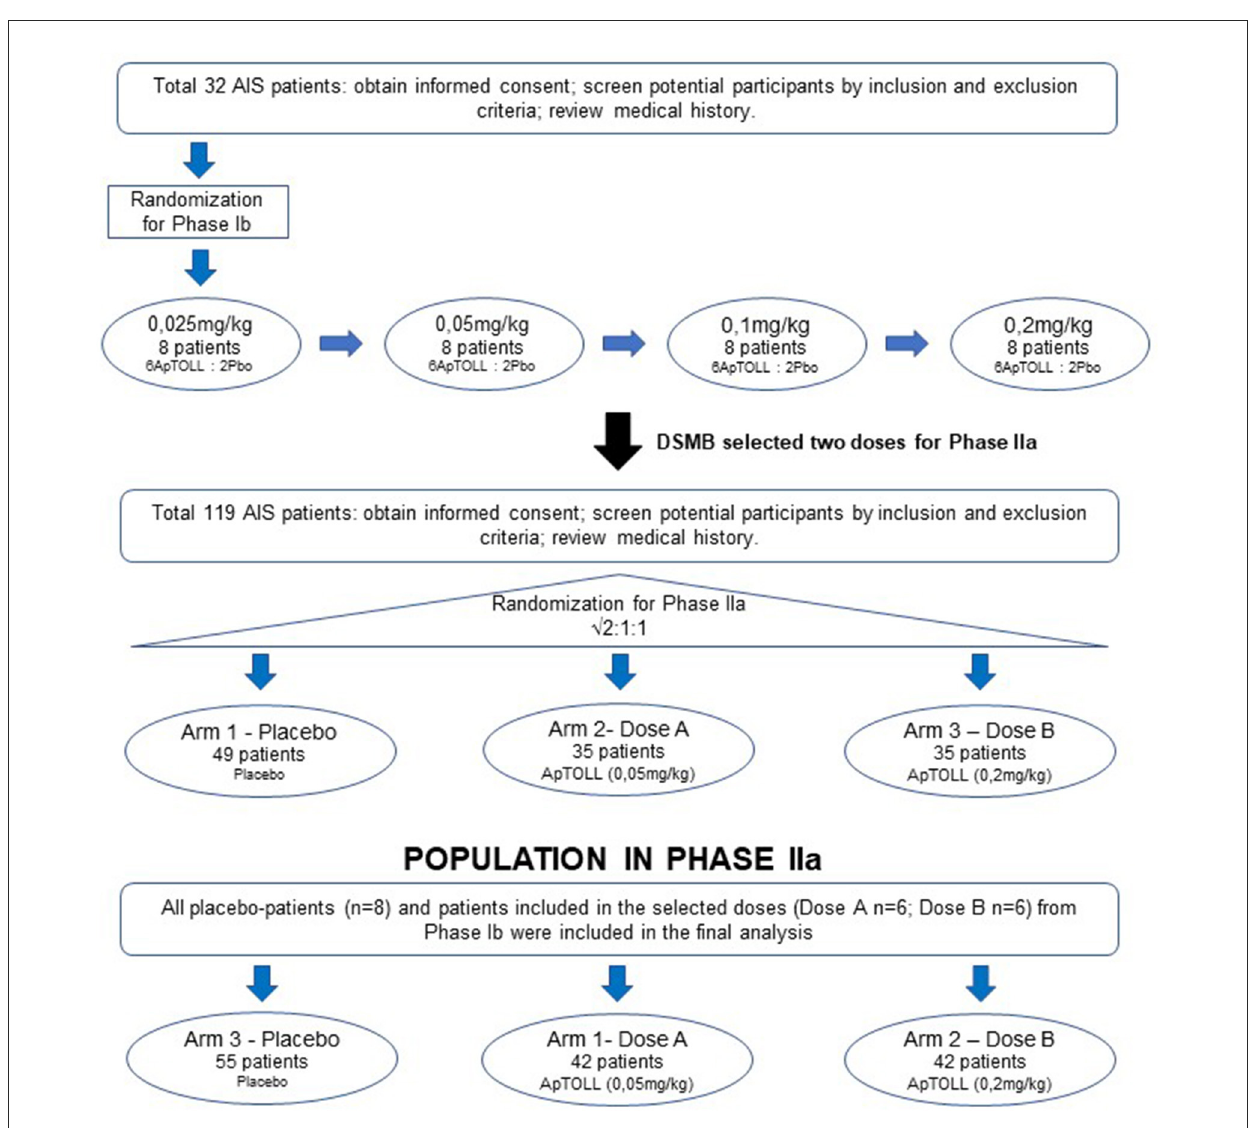
FIGURE1 Scheme of APRIL trial. APRIL is divided into two Phases. Phase Ib is a single ascending dose where 8 patients (6 ApTOLL: 2 Placebo) will be enrolled in 4 sequential ascending dose arms (0.025, 0.05, 0.1, and 0.2 mg/kg). After analyzing safety results from Phase Ib, the DSMB will select two doses to be administered in Phase IIa. In Phase IIa three parallel arms (Dose A, Dose B, and Placebo) will be studied. At the moment of this publication, Phase Ib is completed and the doses 0.05 and 0.2mg/kg have been selected to continue during Phase